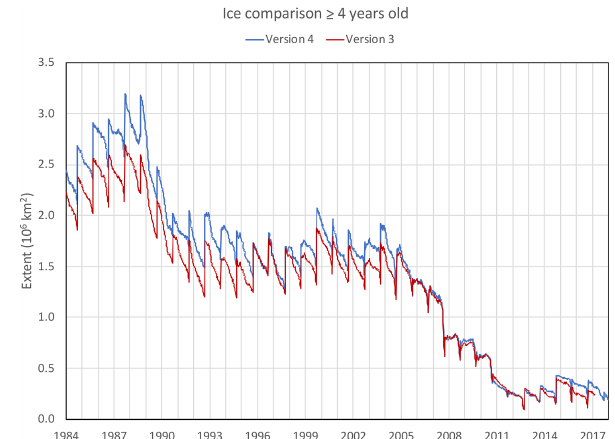
Figure 9. Comparison of ice ≥ 4 years old from Version 3 (red) and Version 4 (blue) for 1984–2017.